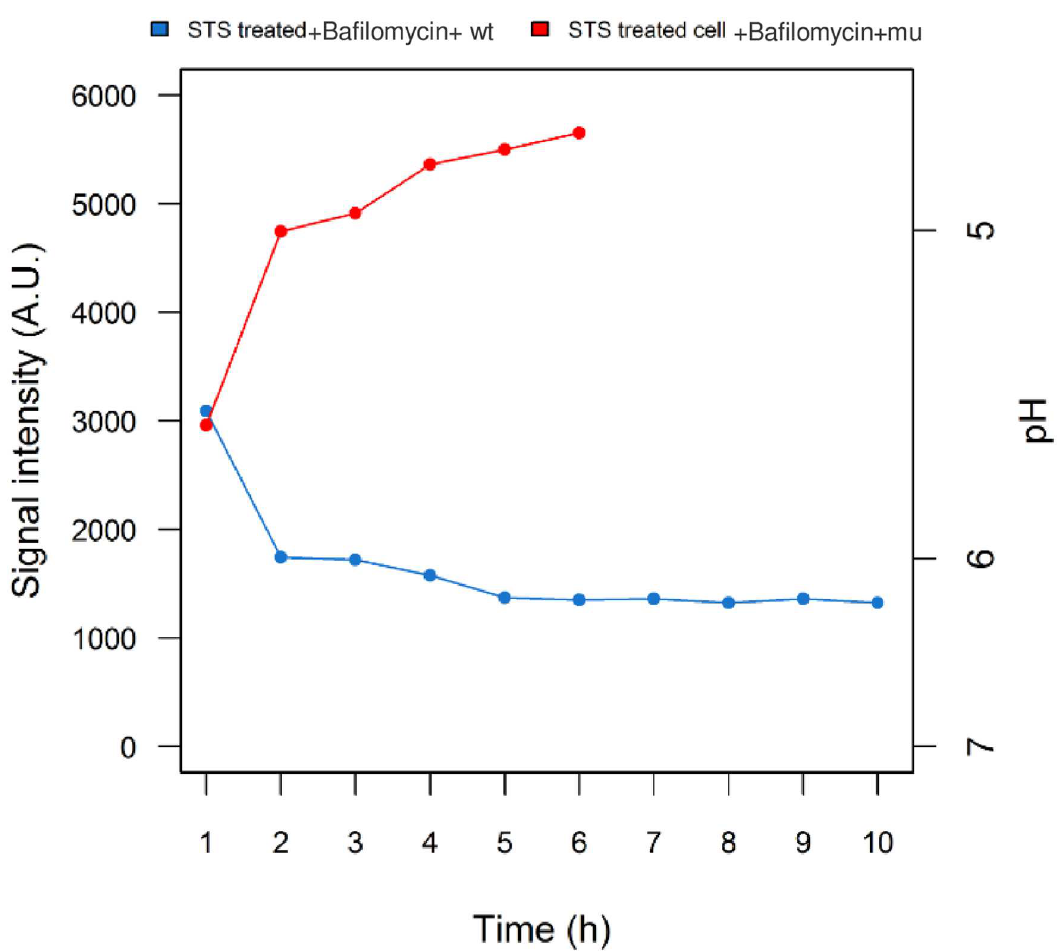
Fig 6. Effect of bafilomycin A1 treatment and inhibition of phagosomal acidification. Despite the inhibitoryeffect of bafilomycin on phagosomes-lysosome degradation, in the presence of melanin the engulfment of conidia and inhibitionof intra-cellular acidification were not affected and the conidiawere localisedin the phagolysosome. Wild-type infection preventedacidificationof phagosome, while the pksP mutant was not able to recover the acidic pH.